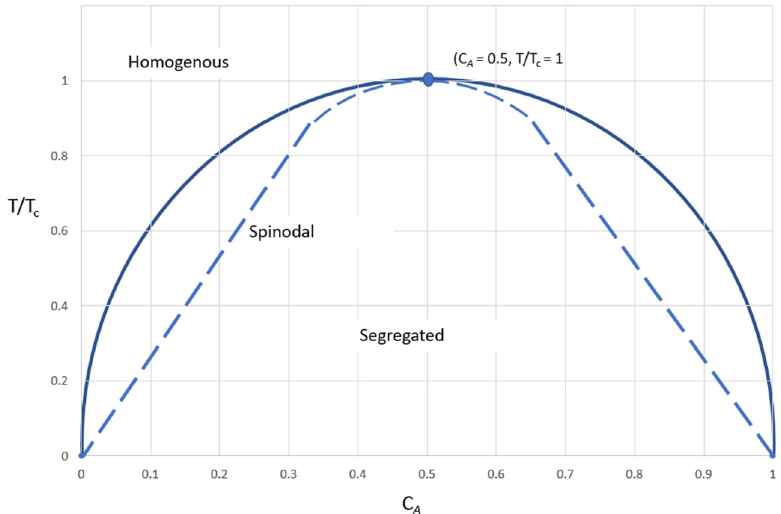
Figure 9. Phase diagram of a binary mixture, AB. Adapted with permission from [79] Patterson et al., Drug Development and Industrial Pharmacy, published by Taylor & Francis, 2008.